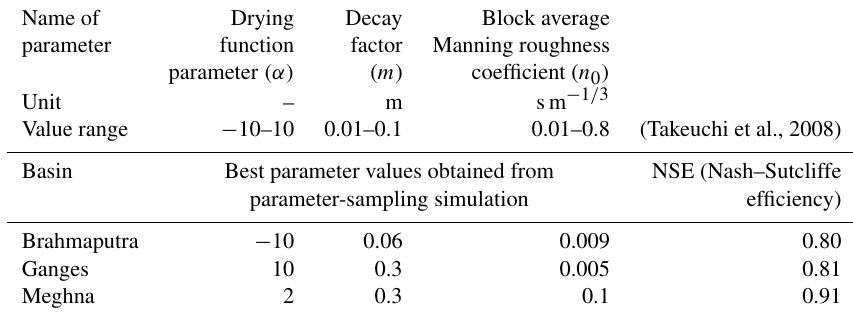
Table 1. BTOPMC sensitive parameters and their optimal parameter values with simulation performance.